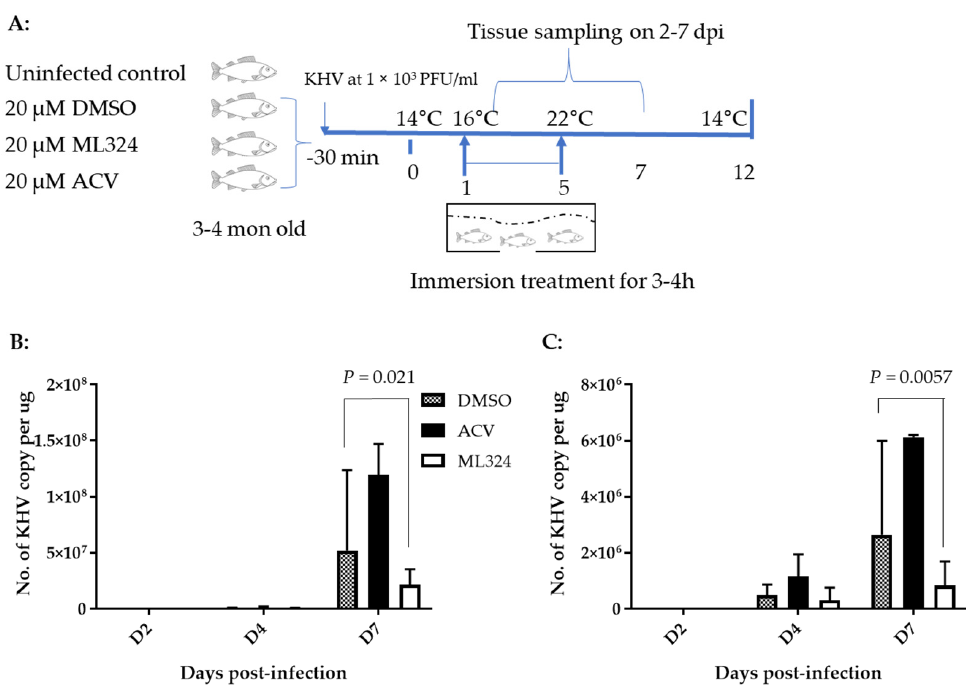
Figure 6. Schematic of the experimental protocol and CyHV-3 genome copy numbers in gill and vent of koi. ( A ) Four groups of koi at 20 koi per group or 30 koi with 10 koi in 3 different tanks per treatment group, at about 3–4 months old, were kept separately in a 3 ft tank with flow through water maintained at 14 ° C to 22 ° C during the first 5 days post-infection, then kept at 22 ° C for 2 days, with the temperature lowered to 14 ° C at a rate of 2 ° C per day. The treatments were given daily on days 1 to 5 post-infection via immersion bath containing 20 µ M ML324, ACV, or dilution media DMSO. CyHV-3 genome copy numbers were estimated in intestines ( B ) and gills ( C ) collected on days 2, 4, and 7 post-infection.